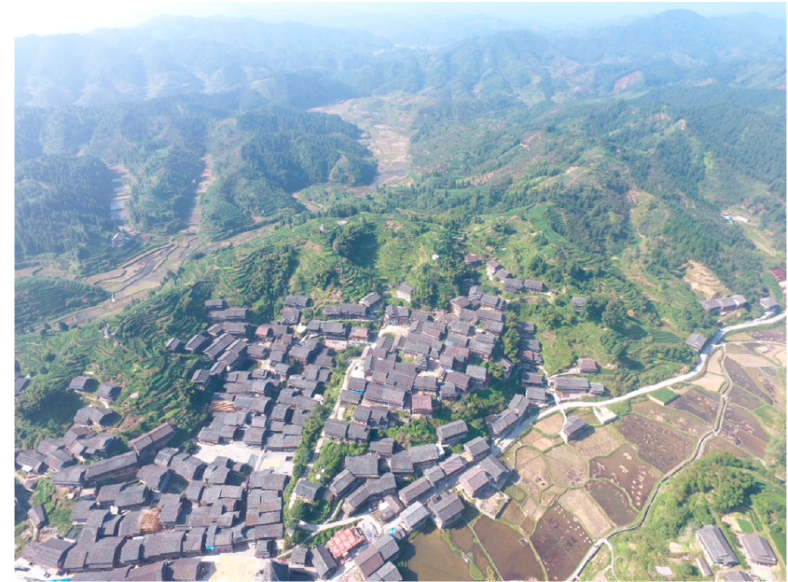
Figure 1. Aerial photo of Gaoyou village (photographed in 2017). Table 1. Official information about Gaoyou village.